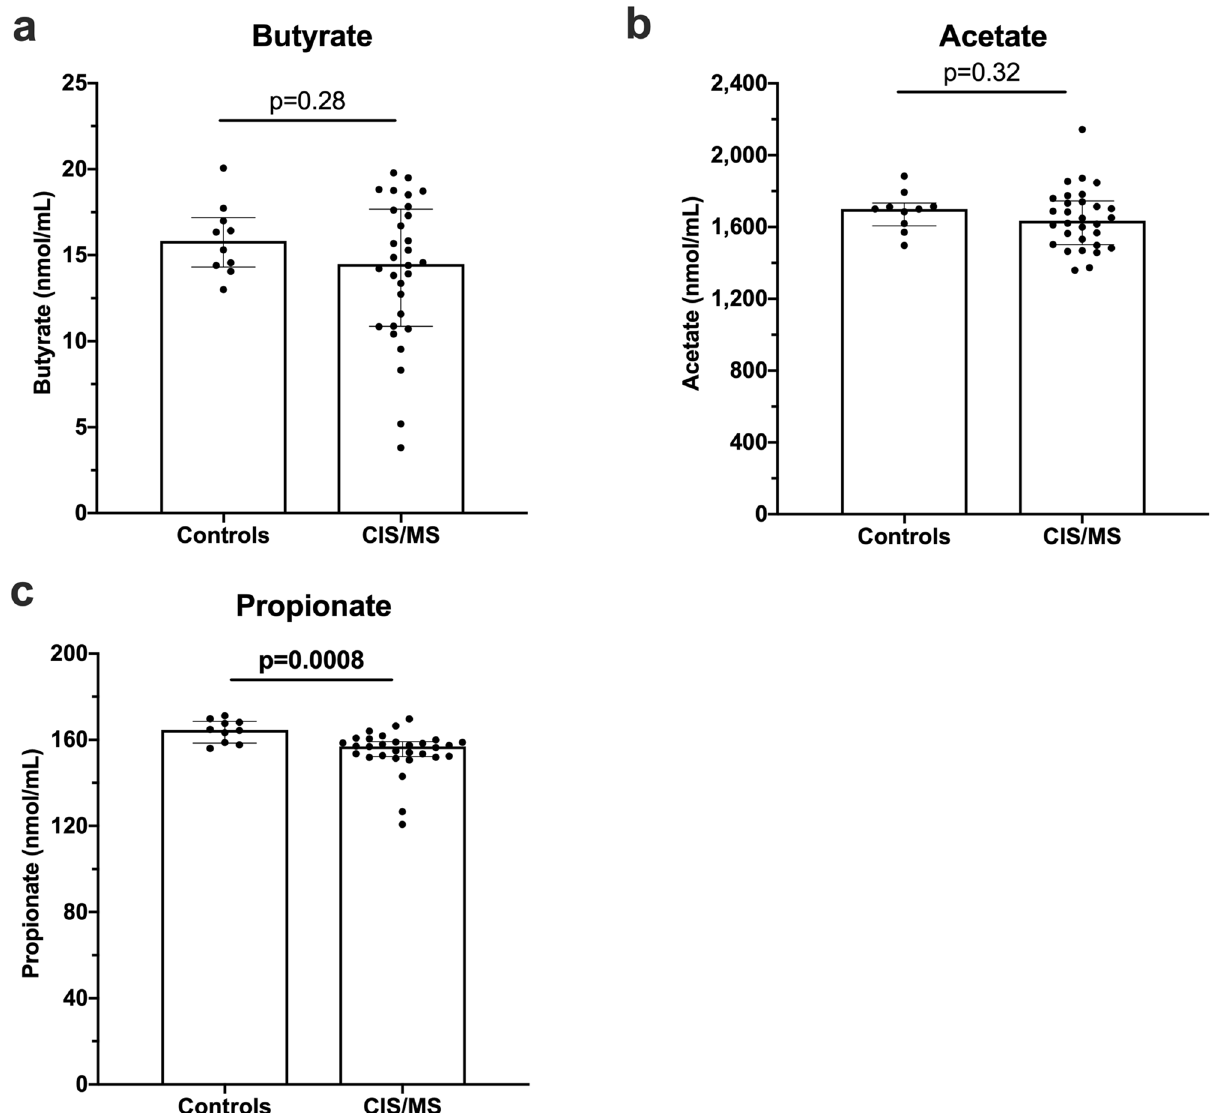
Figure 1. SCFA levels in serum from controls (n = 10), and patients with CIS or MS (CIS/MS; n = 30). (a) Butyrate , (b) acetate, and (c) propionate levels. Bars show median and interquartile range. Comparisons were made using non-parametric tests (Mann–Whitney tests for two